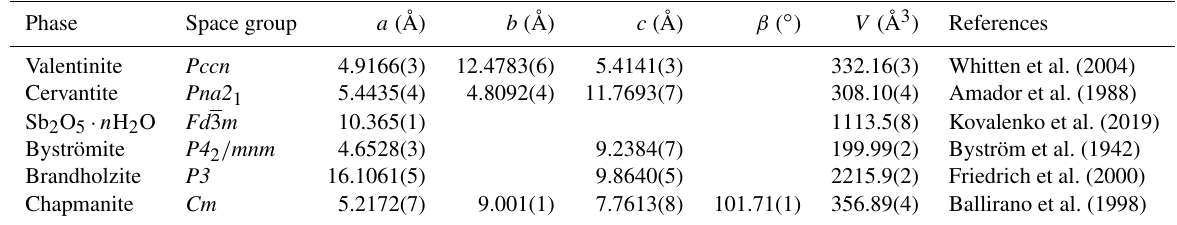
Figure 1. Fragment of the chapmanite structure, showing the tetrahedral sheets (cyan), dioctahedral sheets (brown) populated by Fe 3 + , and the Sb 3 + atoms (gray) bonded to three oxygen atoms in the dioctahedral sheets. Red balls represent oxygen atoms. Constructed from the data in Ballirano et al. (1998). Table 2. Lattice parameters of the studied antimony phases. Lattice parameters constrained by symmetry are not listed. Only the chapmanite sample was natural. Nominal chemical formulae are listed in Table